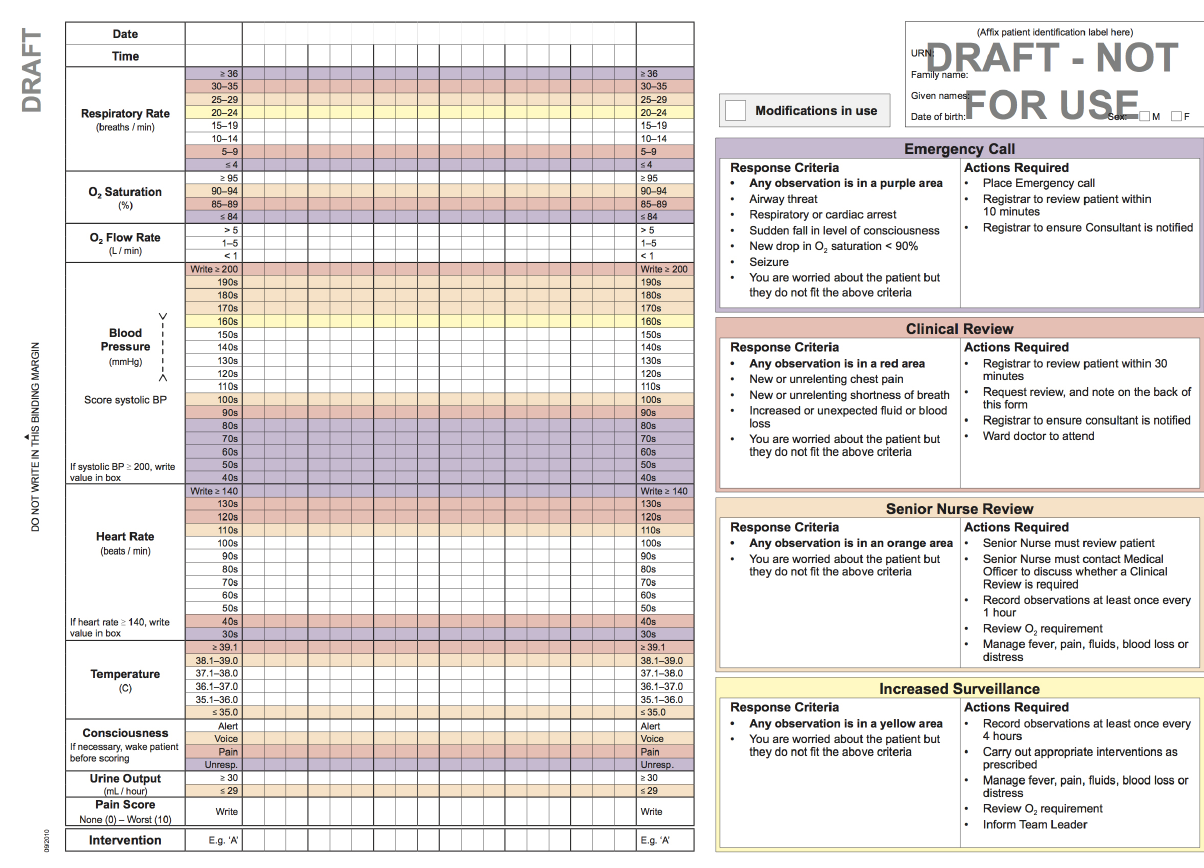
Figure 1. Example ORC, for 4-response level